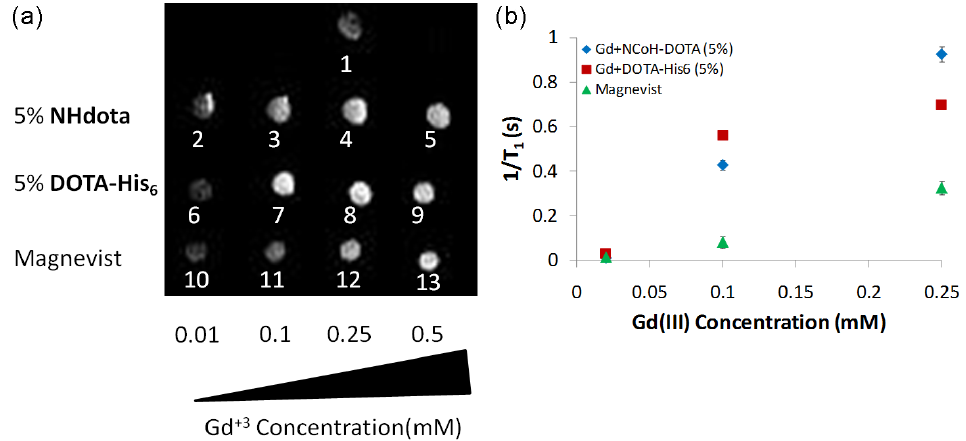
Figure 4. MRI analysis of microflorettes containing NCoH with NHdota (5%) and DOTA-His 6 (5%) with increasing concentration of Gd(III), compared to the commercially available Magnevist depicted as ( a ) T 1 -weighted images and ( b ) longitudinal relaxation rates (1/T 1 ) versus the concentration of Gd(III). T 1 -wieghted images in (a) correspond to: 1 — aragose in PBS containg 0.25 mM of Gd(III); 2 – 5 — microflorettes containing 5% of NHdota and increasing concentrations of Gd(III); 6 – 9 — microflorettes containing 5% of DOTA-His 6 and increasing concentrations of Gd(III); 10 – 13 — commercially available Magnevist with increasing Gd(III) concentrations.